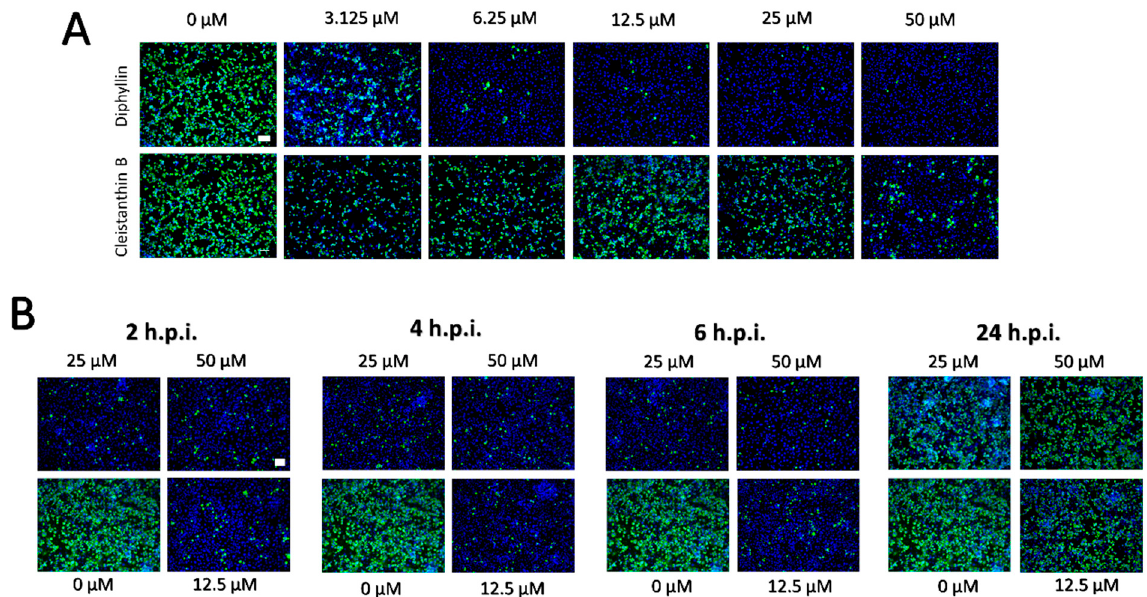
Figure 3. ( A ) Inhibition of SARS-CoV-2 viral antigen expression by diphyllin and cleistanthin B. Compound-treated and virus-infected Vero cells cultivated for 48 h.p.i. were fixed on slides, then stained with a SARS-CoV-2 specific antibody labeled with FITC (green), and counterstained with DAPI (blue). ( B ) Immunofluorescence staining of Vero cell cultures infected with SARS-CoV-2 and treated with diphyllin at 2, 4, 6, and 24 h.p.i. The immunofluorescent staining procedure was identical as in ( A ). Scale bars; 50 µM.